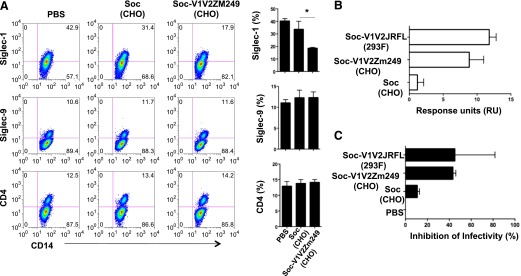
V1V2 protein binds specifically to Siglec-1.(A) Triplicate wells of M-CSF–derived MDMs were preincubated with recombinant CHO-expressed Soc–V1V2Zm249 (CHO) envelope protein, Soc (CHO), or PBS for 30 min at room temperature, and the expression of Siglec-1, Siglec-9, and CD4 was analyzed by flow cytometry. Bar graphs show percentage of expression (means ± sd) of the cell receptors. A representative of 2 independent experiments is shown (*P = 0.02, Mann Whitney test). (B) Siglec-1 was immobilized on a CM5 biosensor chip and the binding (RUs) of CHO-expressed Soc (CHO), Soc-V1V2Zm249 (CHO), or 293F-expressed Soc-V1V2JRFL (293F) recombinant Soc–V1V2 proteins was determined by SPR. (C) MDMs were preincubated with PBS or with recombinant Soc-V1V2 proteins for 30 min at room temperature and infected with HIV-1. Cells were harvested on day 4 postinfection and analyzed for the presence of intracellular p24 by flow cytometry. Bar graphs show the percentage inhibition of infectivity (means ± sd). Data are representative of 2 independent experiments.